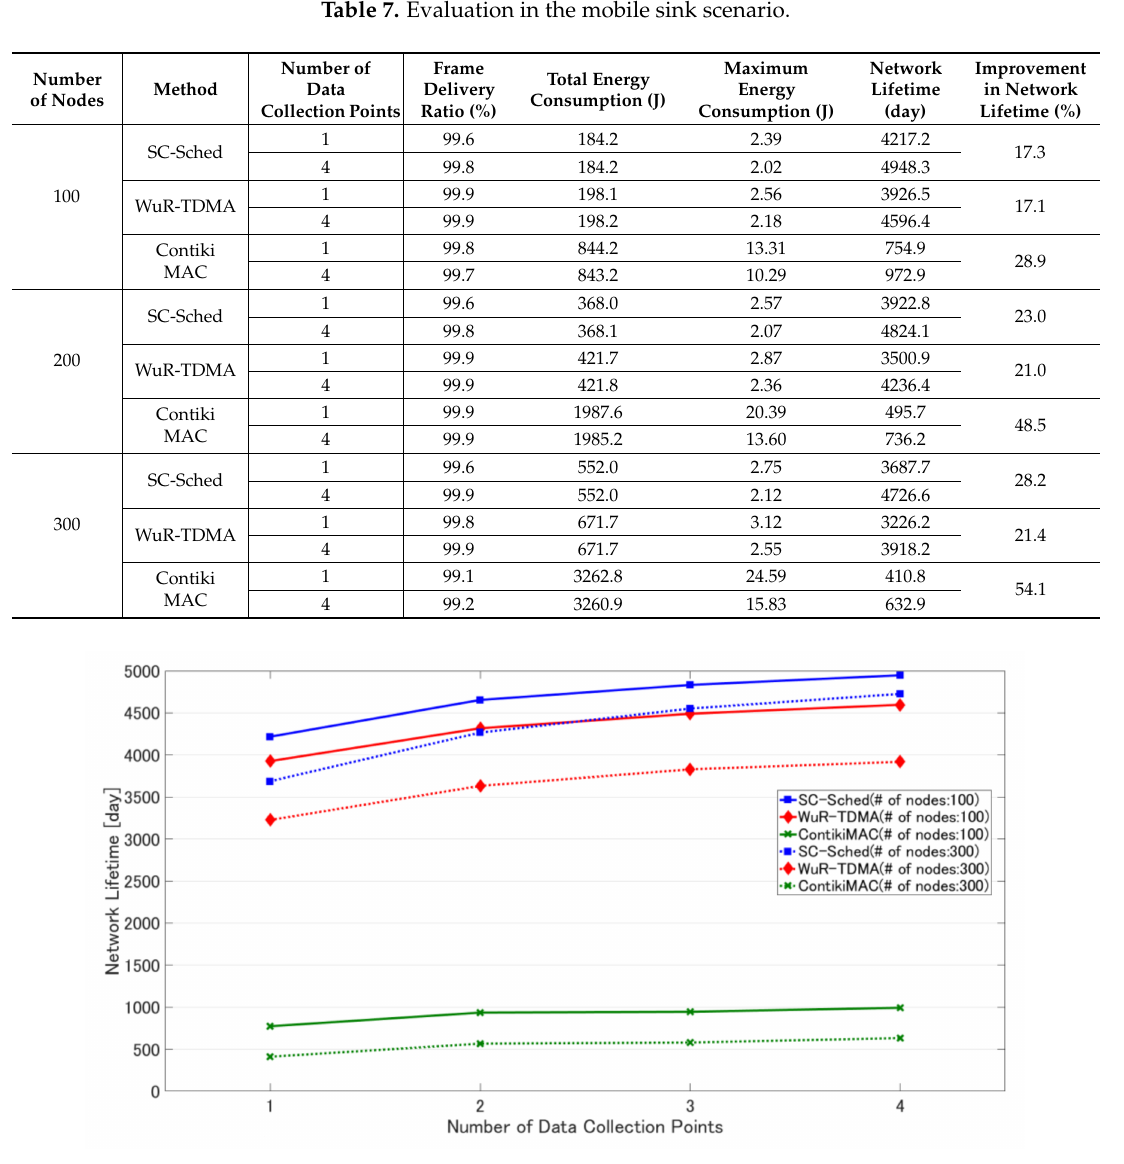
Figure 10. Network lifetime in the three methods under different numbers of data collection